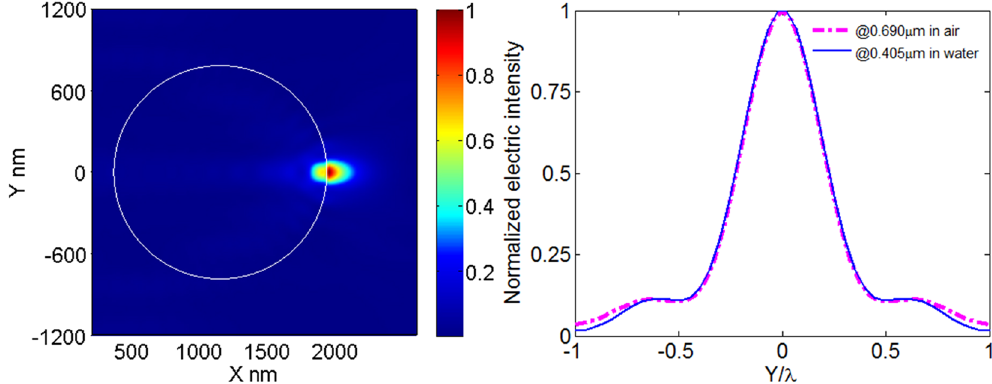
Figure 6. ( a ) Electric intensity distribution around the microsphere immerged in water. The system parameters are: λ